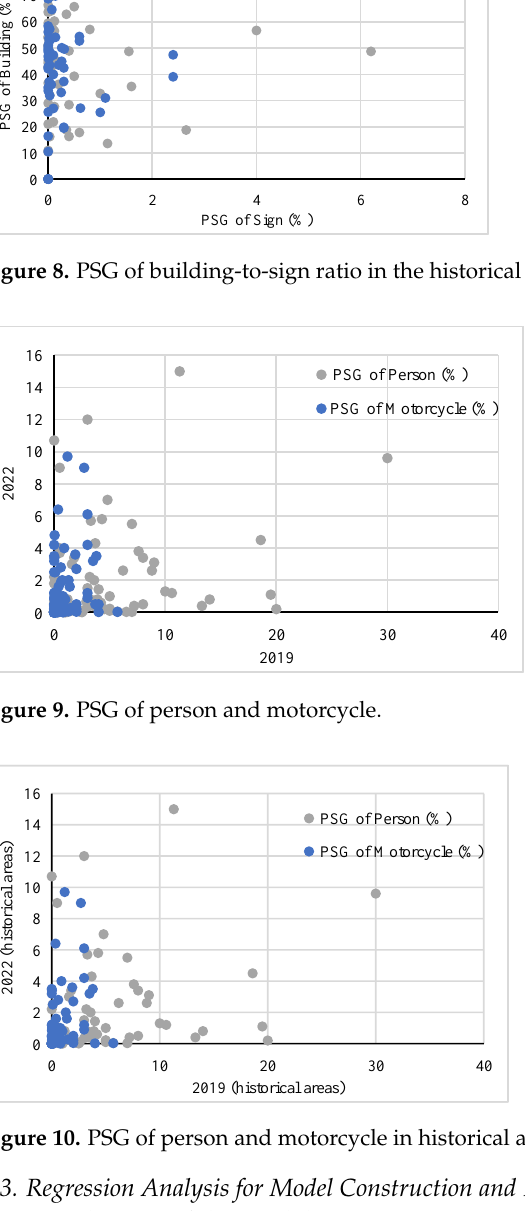
Figure 7. PSG of building-to-sign ratio for selected points before and after the pandemic. Figure 8. PSG of building-to-sign ratio in the historical areas.